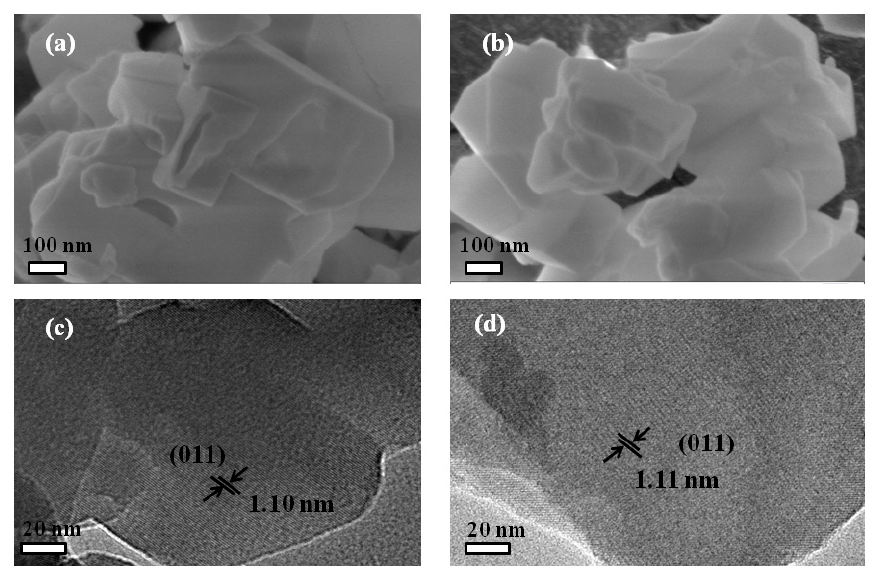
Figure 3. SEM images of ( a ) Z0, ( b ) Z4, and TEM images of ( c ) Z0, ( d ) Z4.